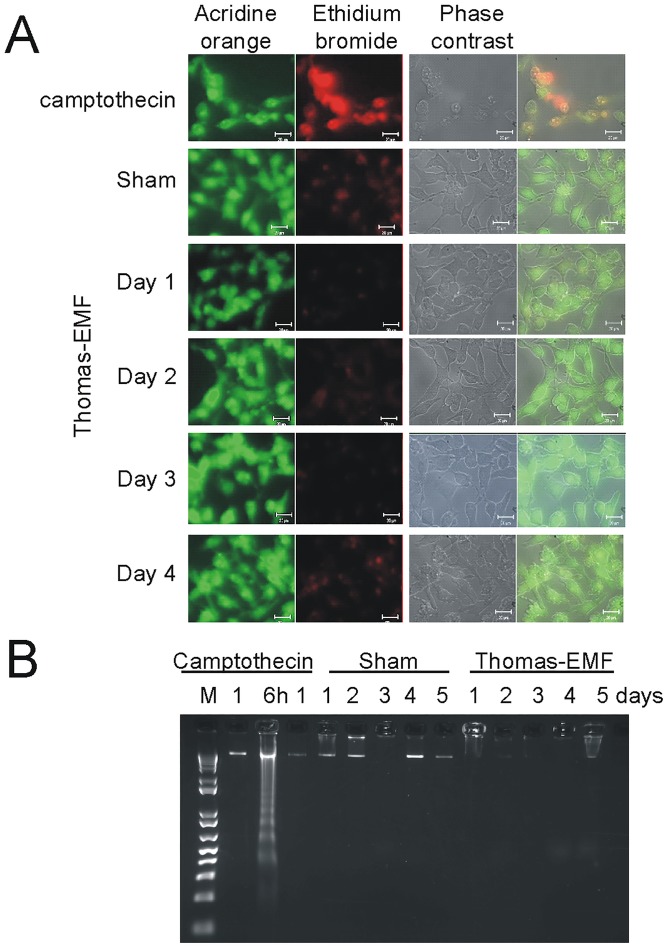
Exposure to Thomas-EMF does not promote apoptosis.A. B16-BL6 cells were treated with sham conditions, 10-6 M camptothecin for 6 h, or Thomas-EMF for 1 h/day for 1, 3, or 5 days. The cells were stained by incubation in 5 μg/ml acridine orange (green) and 5 μg/ml ethidium bromide (red) in PBS, pH 7.4 for 15 min and visualized on an LSM510 fluorescence microscope. B. B16-BL6 cells cultured in 3.5 cm culture dishes were treated with 10-6 M camptothecin for 1, 6, or 24 h (positive control) or exposed to Thomas-EMF or sham conditions for 1 h/day for 1–5 days. Cell were collected, lysed in TE/Triton buffer (0.2% TritonX-100, 10 mM Tris, 1 mM EDTA, pH 8.0), and subjected to centrifugation at 12 000 x g for 15 min. The low molecular weight DNA was treated with RNase and proteinase K and subjected to electrophoresis on an agarose gel containing ethidium bromide. M shows the 1kb DNA marker (Life Technologies).